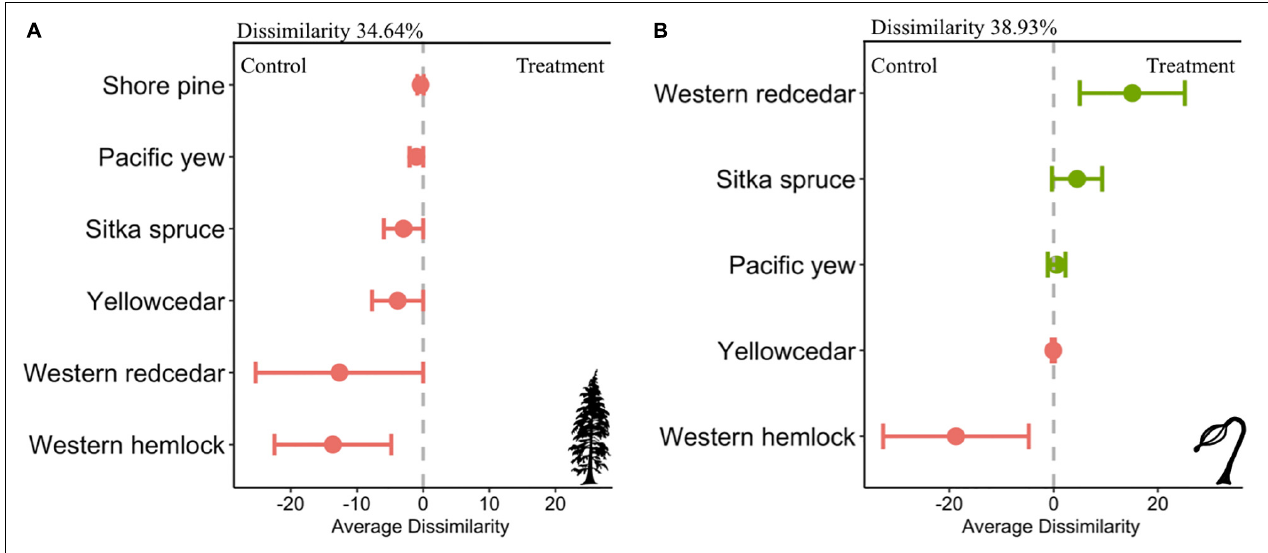
FIGURE 4 | Species-specific average dissimilarity between control and habitation sites for (A) adult tree communities, and (B) regeneration communities. Pink dots denote increases in abundances at control sites relative to habitation sites, whereas green dots denote increases in abundances at habitation sites relative to control sites. Average dissimilarity was derived from similarity percentage analyses evaluating adult and regeneration communities’ compositions within habitation and control sites. Error bars represent the standard deviation of the species contribution to the between-group